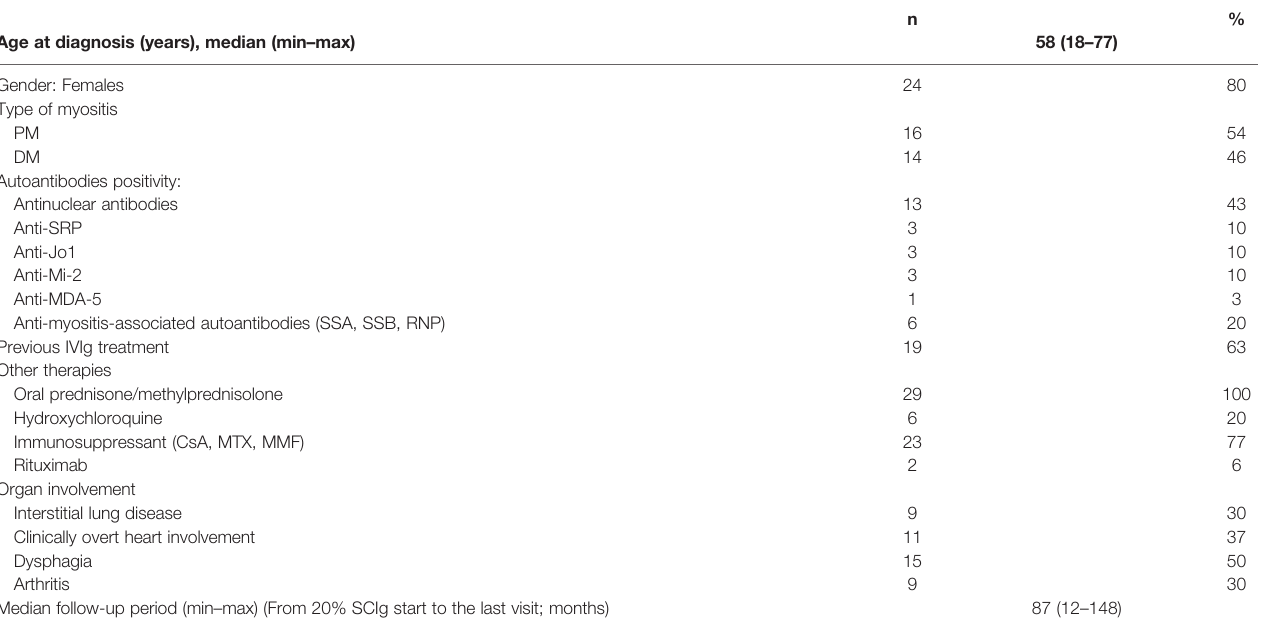
TABLE 1 | Baseline characteristics of PM and DM patients (n =